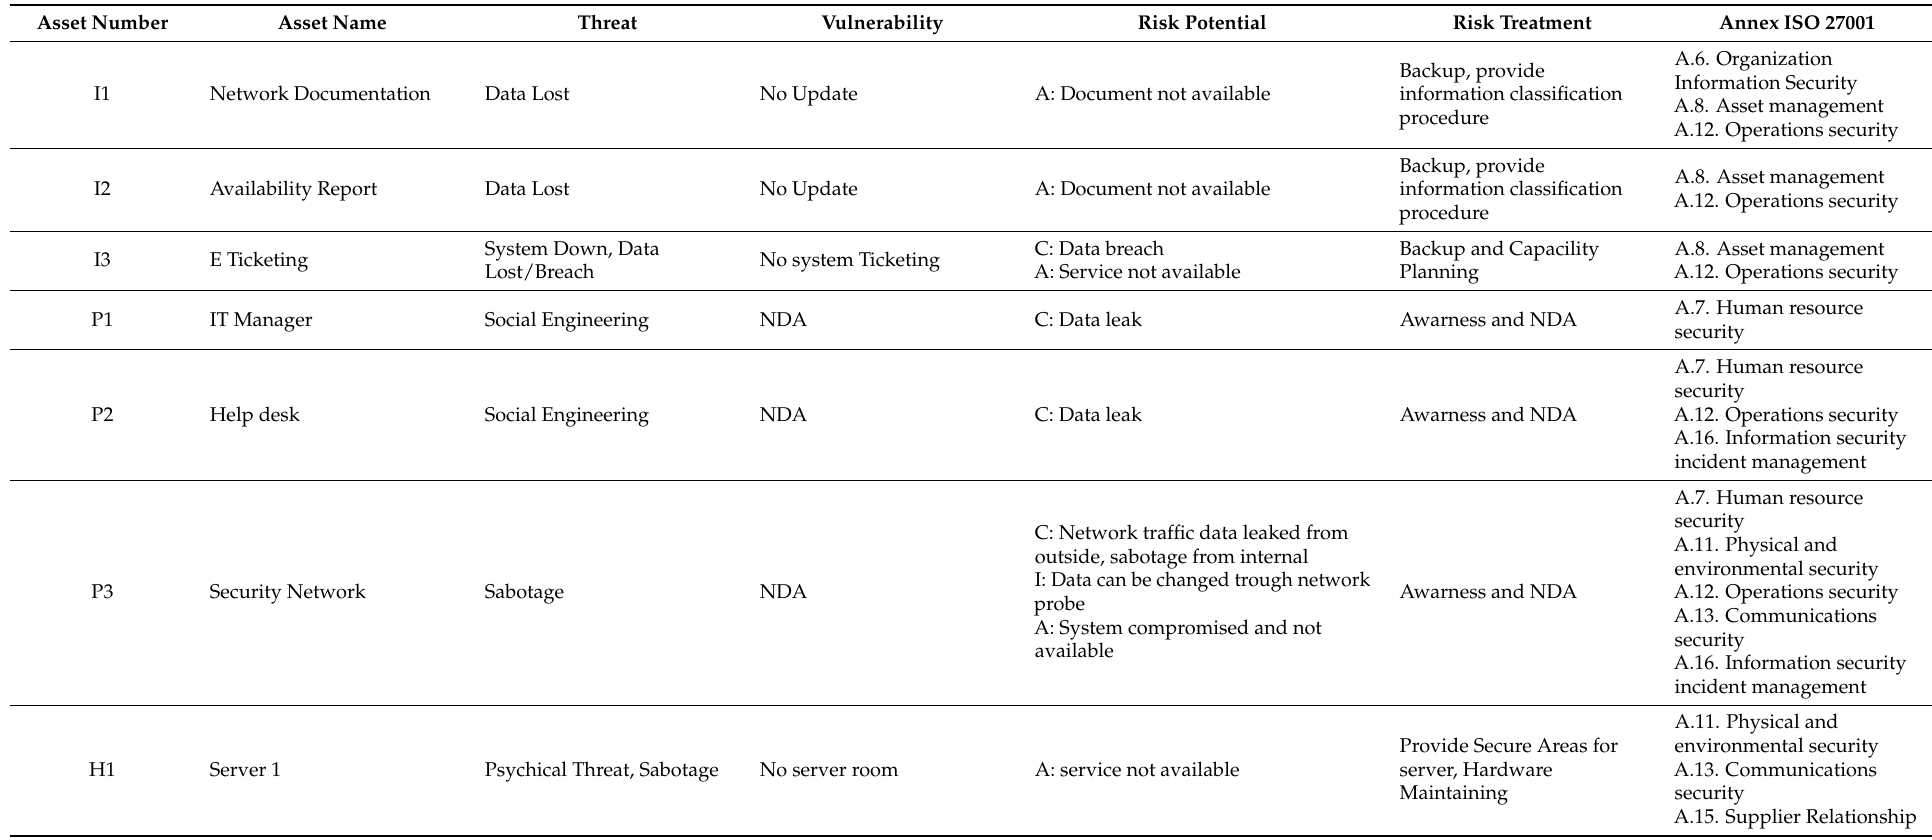
Table A1. Risk Identification and Risk Control for Network